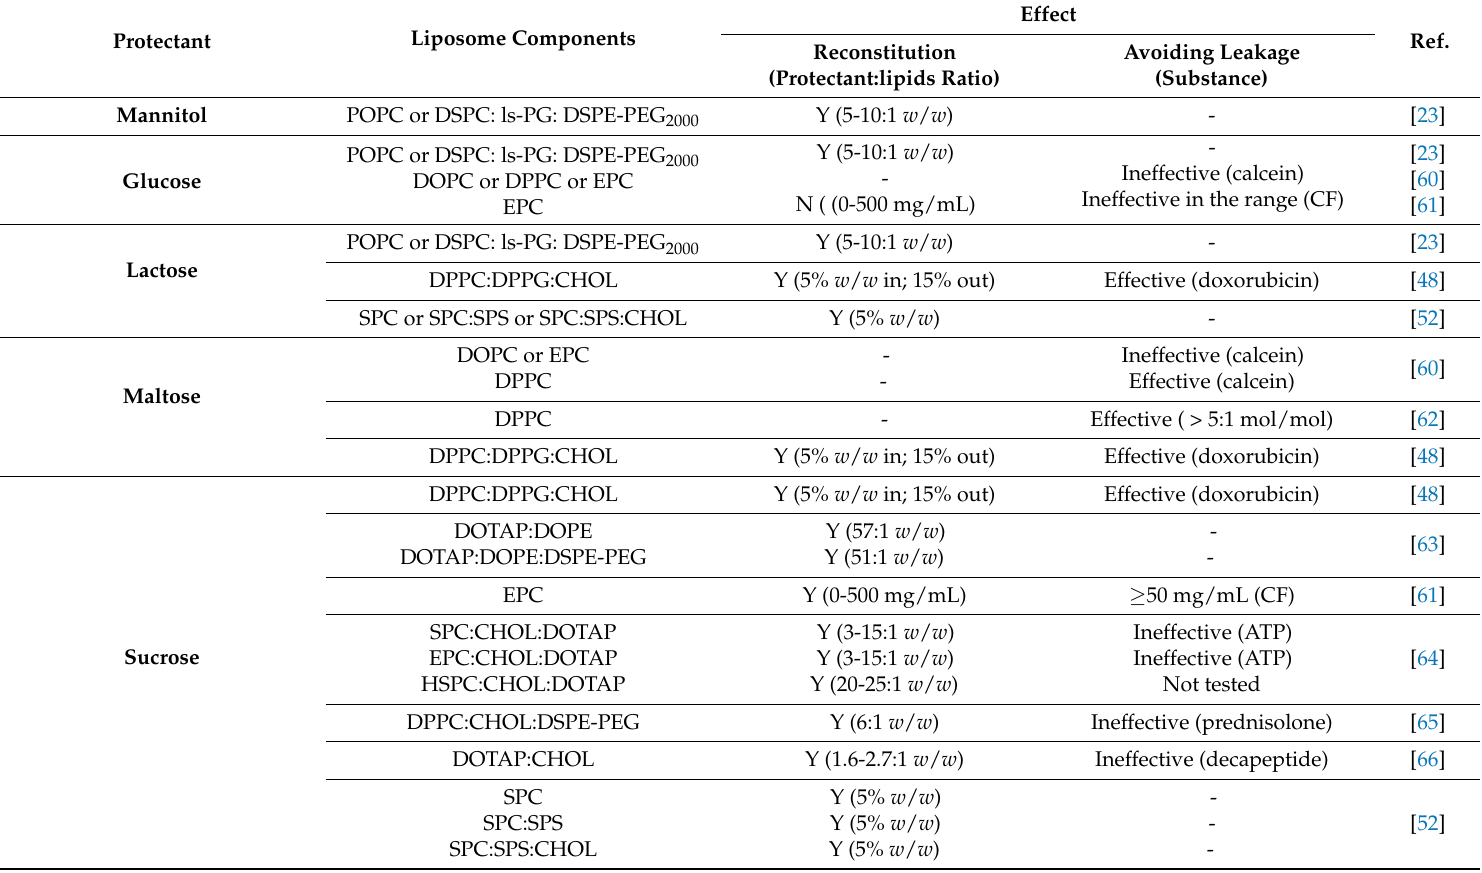
Table 2. Overview of the main excipients tested as protectants of liposomes upon freeze-drying. To allow a quick comparison of the data, it was arbitrarily assumed that the reconstitution is acceptable (Y) when a monodisperse population was obtained upon re-hydration and the hydrodynamic diameter of the resuspended liposomes was lower than 3 times with respect to the value of the not freeze-dried formulation. Leakage was considered avoided (effective) if the retention of the entrapped substance after freeze-drying was at least 90% of the original